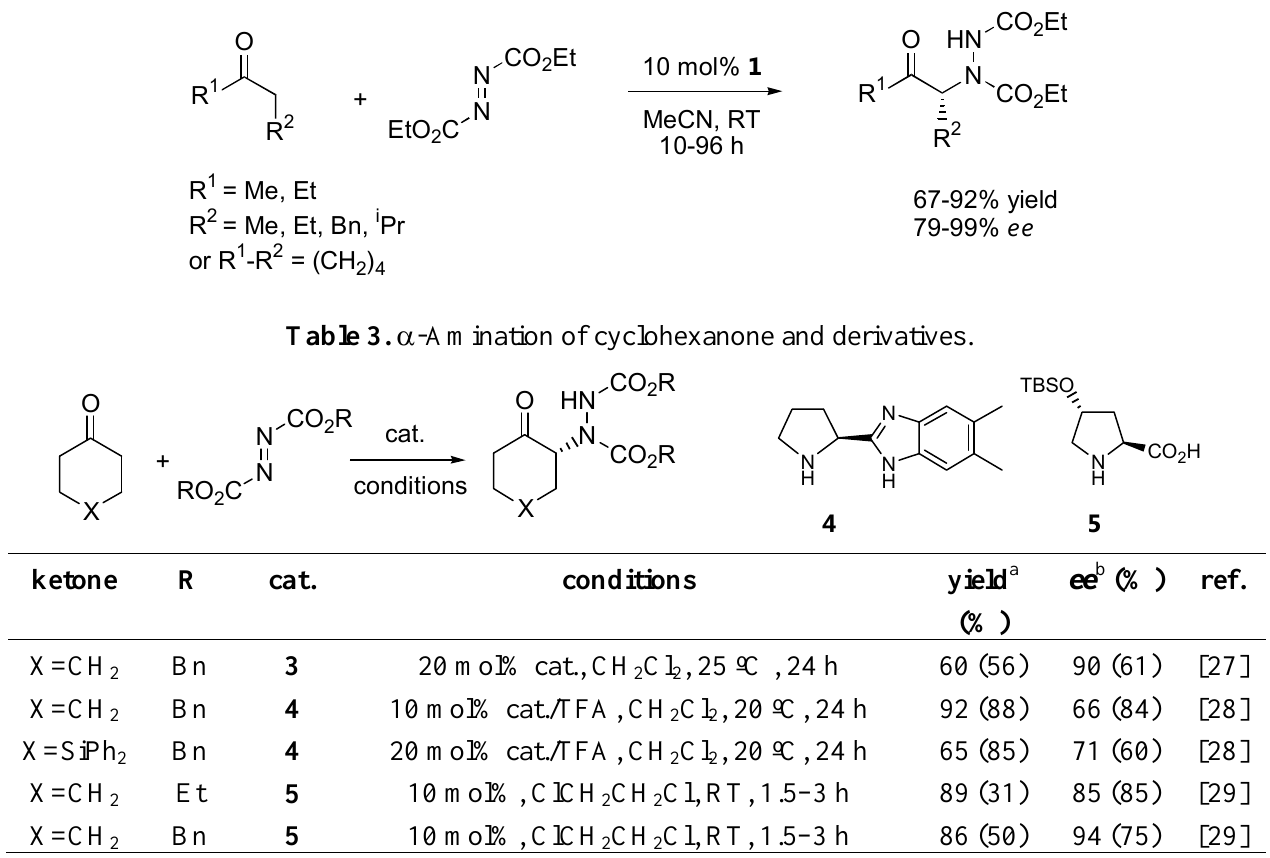
Figure 2. L -Proline-catalyzed  -amination of ketones [26].